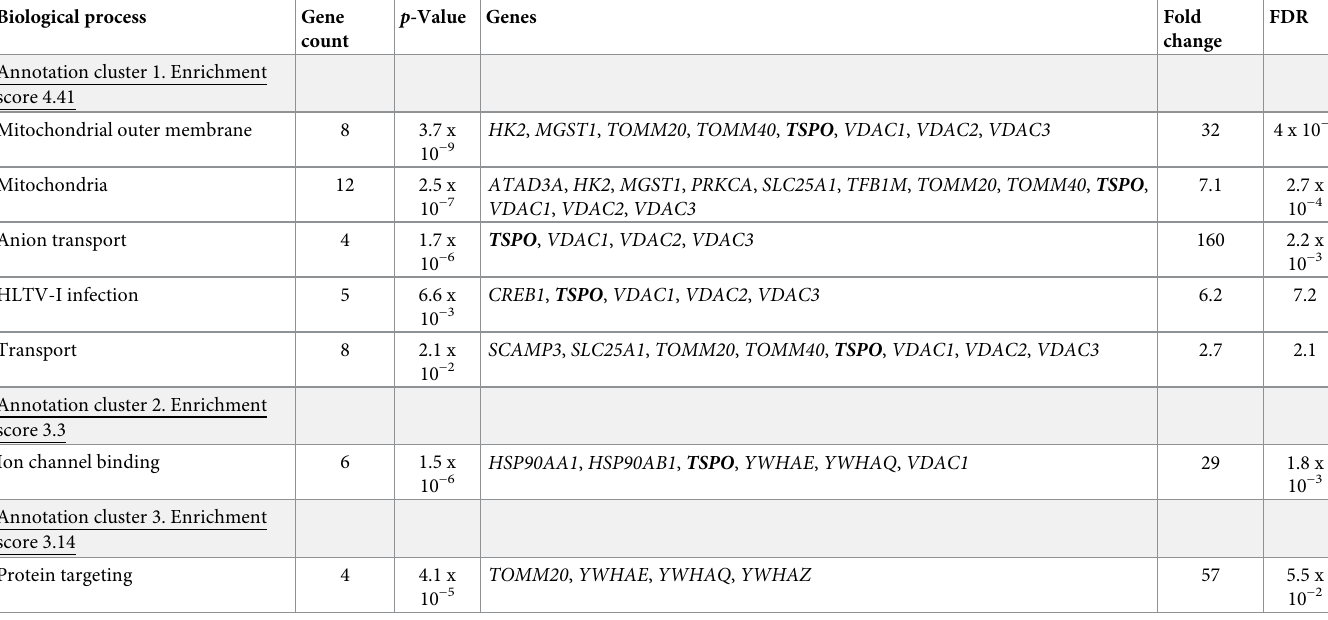
Table 1. Functional annotation cluster analysis of TSPO binding partners extracted from from V5-tagged TSPO WT and TSPOA 147T -transfected samples and detected by MS. Top 3 DAVID Bioinformatics Resources annotation clusters (n = 31 proteins from three biological replicates). Fold change refers to enrichment in com- parison to the whole human proteome (background